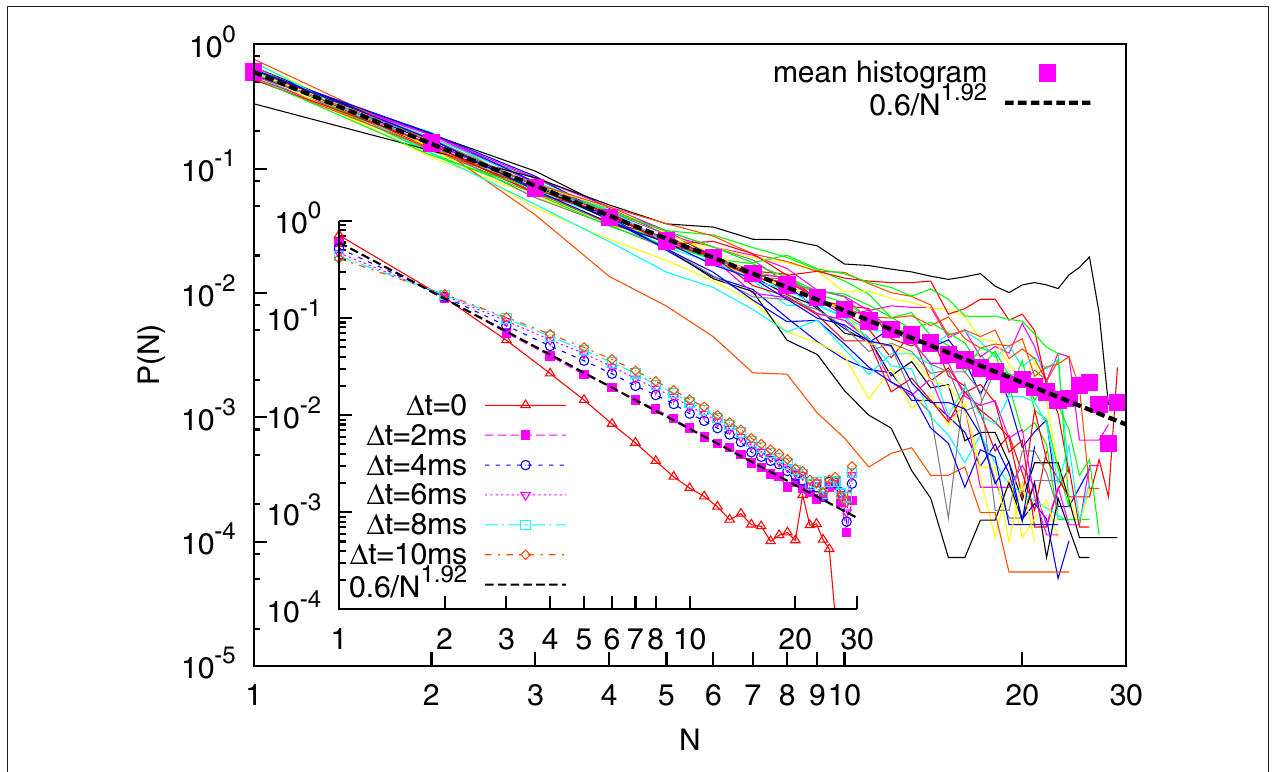
FiGuRE 2 | Main figure: Solid curves are the probability densities for avalanches sizes for 30 subjects; Solid squares denote the averaged probability density; the dashed line denotes a corresponding best fit with